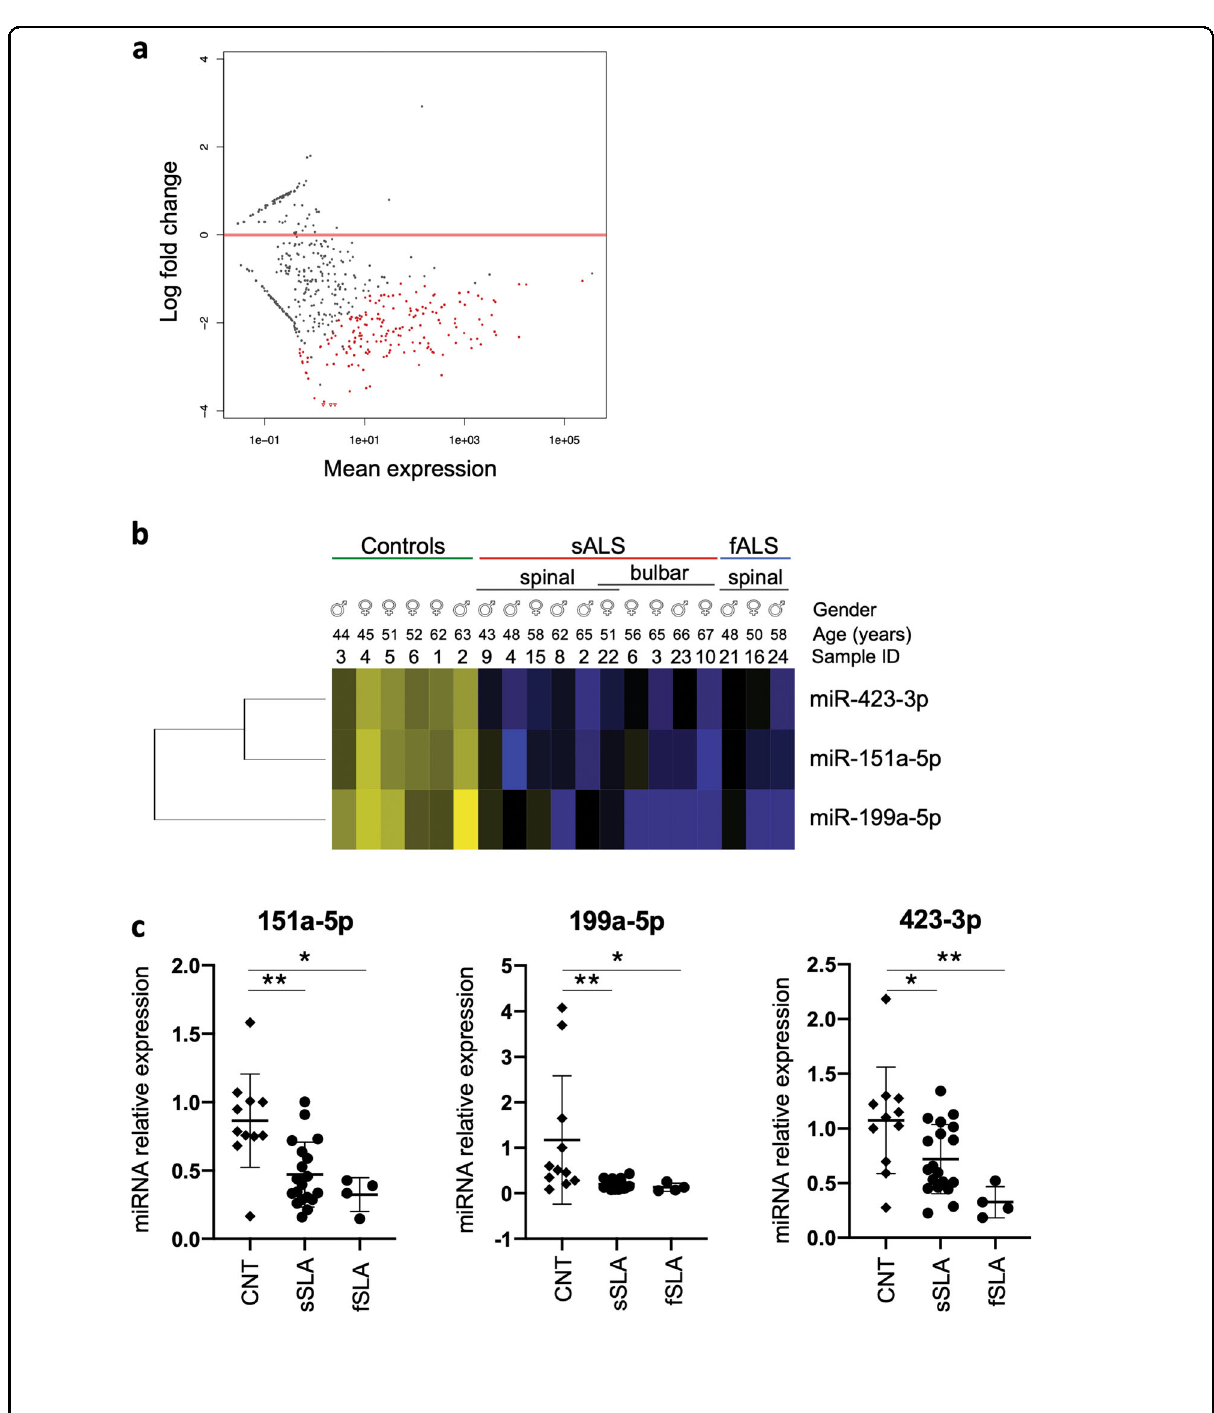
Fig. 1 NGS analysis of miRNAs expression in healthy and ALS patients. a MA plot and b expression heatmap of miRNAs expression in healthy and ALS patient sera showing selected downregulated serum miRNAs from sALS and fALS patients compared with healthy controls (CNT). Blue represents downregulation and yellow represents upregulation. Gender, age, and samples ID are indicated. In the scatter plot, log2 fold change of miRNA expression values between healthy and ALS patient sera are plotted against the mean of DESeq2 miRNA normalized read counts. Negative fold changes re fl ect depletion in ALS patient sera. Dots are colored red if the adjusted p -value for the differential expression test is less than 0.1. c qPCR validation by relative quanti fi cation of miR-151a-5p, miR-199a-5p and miR-423-3p in serum samples of 19 sALS and 4 fALS patients with respect to 11 healthy controls. All data were normalized for a spiked miRNA (cel-lin-4) and expressed as fold change with respect to a healthy control set to a value of 1.